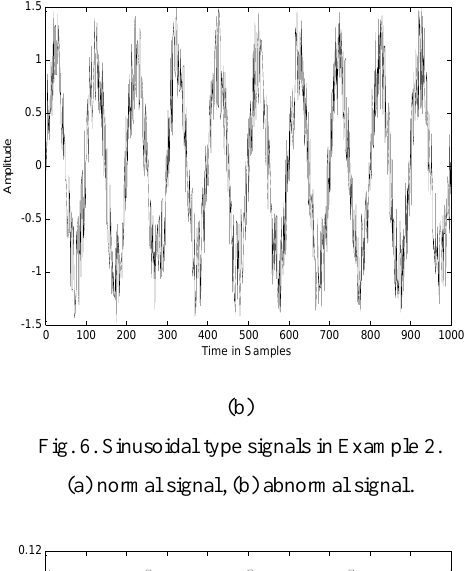
Fig. 6. Sinusoidal type signals in Example 2. (a) normal signal, (b) abnormal signal.